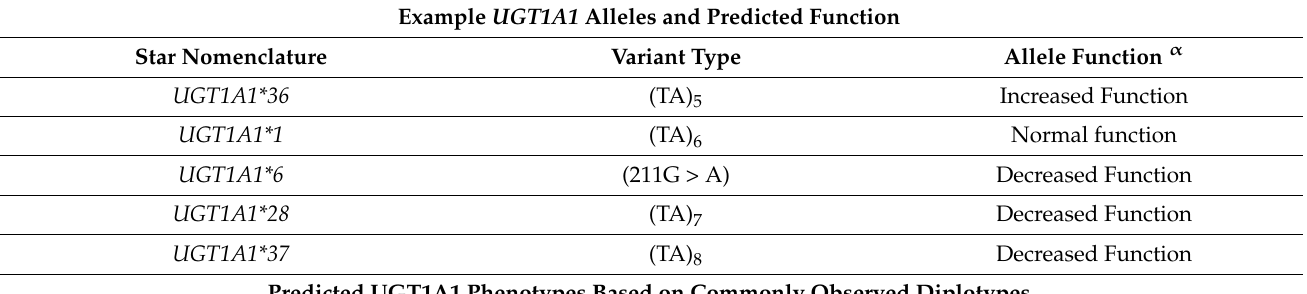
Table 1. Example UGT1A1 alleles, predicted phenotype function, and phenotype frequencies among racial/ethnic groups. Example UGT1A1 Alleles and Predicted